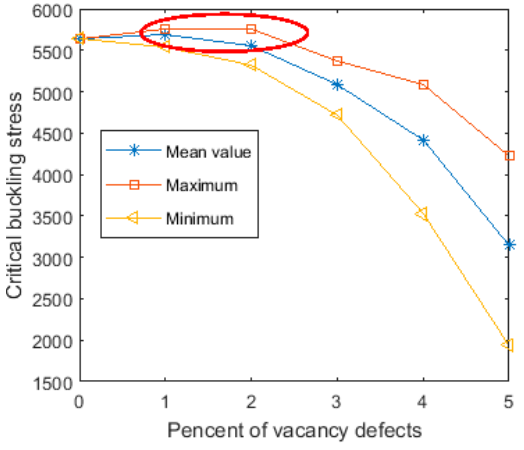
Figure 6. Interval results of MC–FEM.